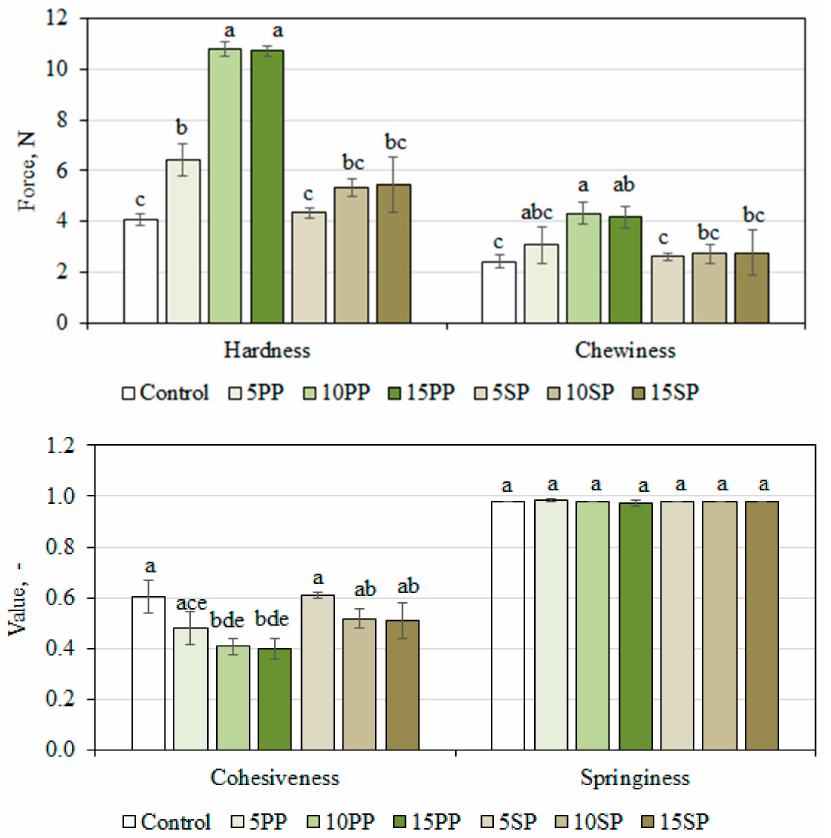
Figure 2. Texture properties of the bread samples. The results are mean ± standard deviation (n = 3). The different letters show significance difference ( p <